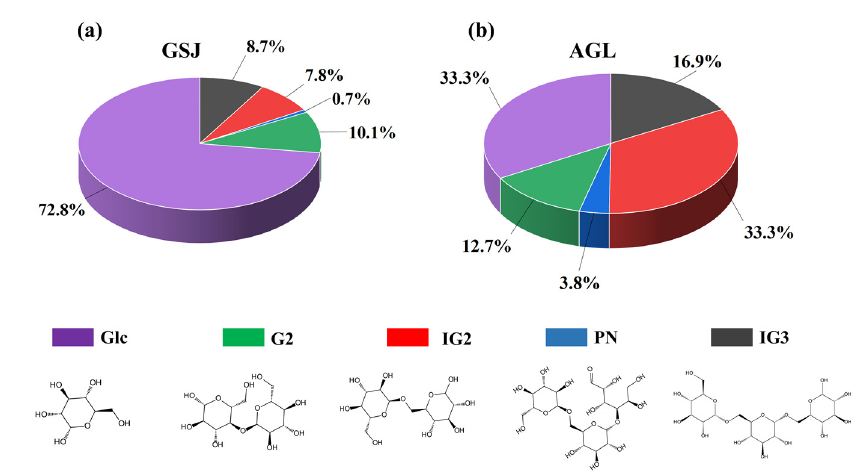
Figure 3. Analysis of transglycosylation products. The transglycosylation products of maltose by GSJ ( a ) and AGL ( b ).